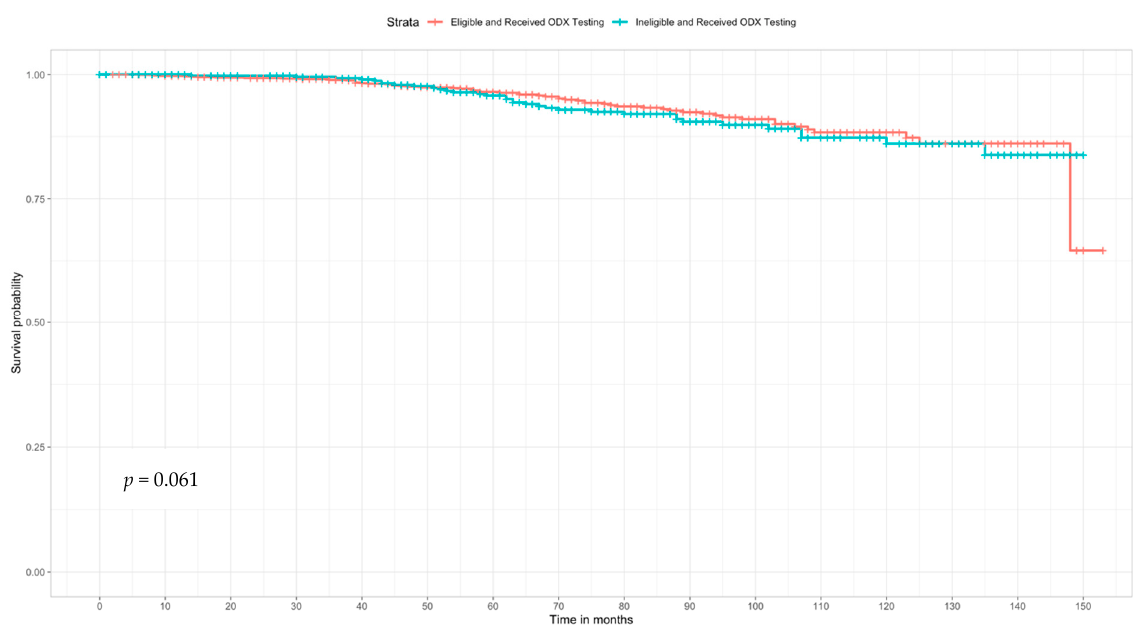
Figure 4. Kaplan–Meier curve of all Latina/Hispanic women who received ODX testing by eligibility ( n = 1608).